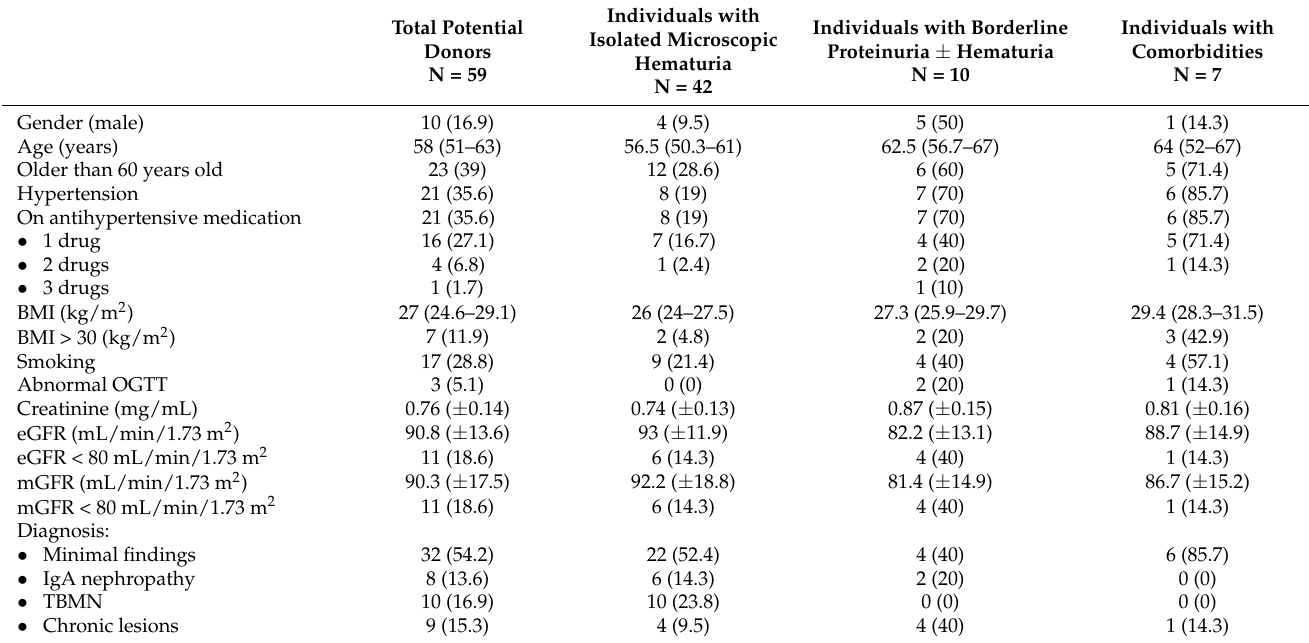
Table 1. Demographic and clinical characteristics of potential living kidney donors who underwent a pre-transplant kidney biopsy, classified by biopsy indication [N (%) or Mean ( ± SD) or Median (IQR)]. Individuals with Total Potential Individuals with Borderline Individuals with Isolated Microscopic Donors Proteinuria ± Hematuria Comorbidities Hematuria N = 59 N = 10 N = 7 N = 42 10